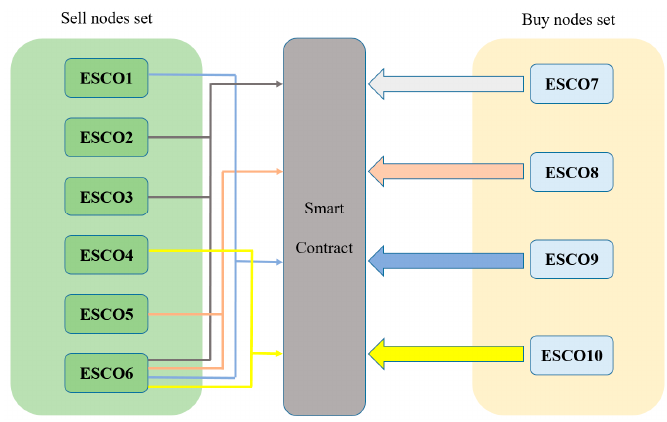
Figure 9. The energy scheduling process of EBN-IESCOM.